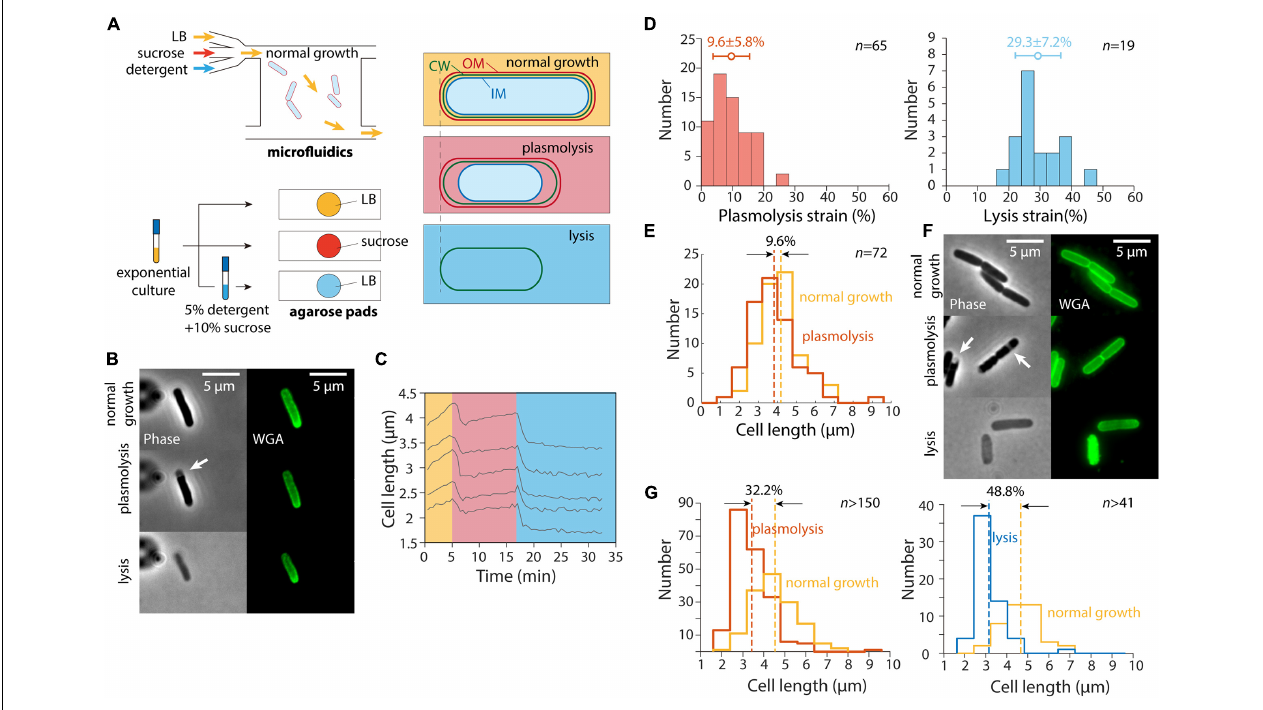
FIGURE 1 | Population-averaged relative length change after hyperosmotic shock is greater on agarose pads than from single-cell tracking in microfluidic devices. (A) Schematic of microfluidic (top) and agarose pad-based (bottom) measurements of length changes (right) due to hyperosmotic shock (plasmolysis) and detergent-mediated lysis. (B) Relative to normal growth (top), cells exposed to a hyperosmotic shock in a microfluidic flow cell (middle) decreased in length and exhibited plasmolysis (white arrow). Subsequent lysis due to detergent treatment (bottom) resulted in further shrinkage. Shown are phase contrast images (left) and fluorescence from the wall label WGA-AF488 (right). (C) Quantification of cell length dynamics for 5 representative cells for the experiment in panel B . Cell elongation was inhibited after the shock. (D) Quantification of the mechanical strain (extension relative to the smaller state) in cell wall length due to hyperosmotic shock (left) and detergent treatment (right). The additional strain revealed by detergent treatment shows that the stiffness of the outer membrane is comparable to that of the cell wall (Rojas et al., 2018). (E) Population-averaged cell wall length of the same set of cells in a microfluidic device before and after hyperosmotic shock yielded a similar estimate of plasmolysis strain as in panel D . (F) Cells imaged during normal growth in a test tube (top), on agarose pads with 20% sucrose to cause a hyperosmotic shock (middle, white arrows indicate plasmolysis bays), and after detergent treatment to cause lysis (bottom). (G) The relative change in length of cells on an agarose pad before and after a hyperosmotic shock (left) was substantially greater than the relative length change in a microfluidic device shown in panel D , as was the relative length change after lysis